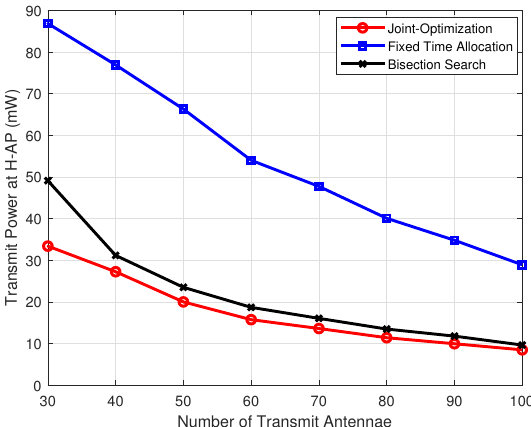
Figure 3. Transmit power versus the number of transmit antennae at the hybrid access point (H-AP) when N =